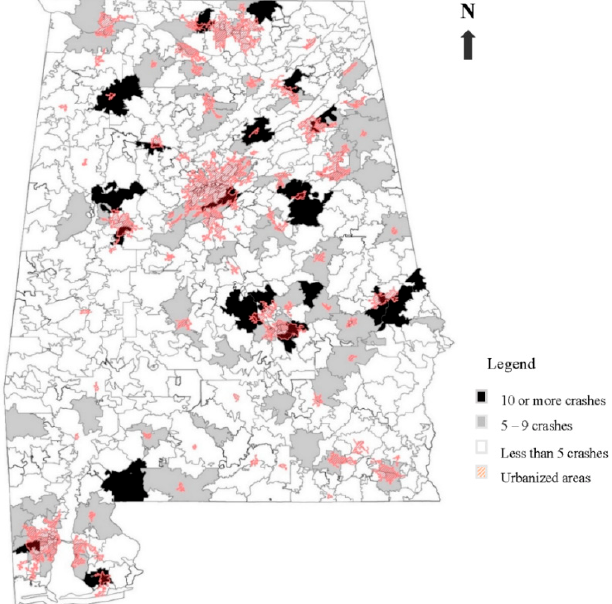
Figure 1. Residence of Young Drivers Involved in Crashes Close-to-Home.